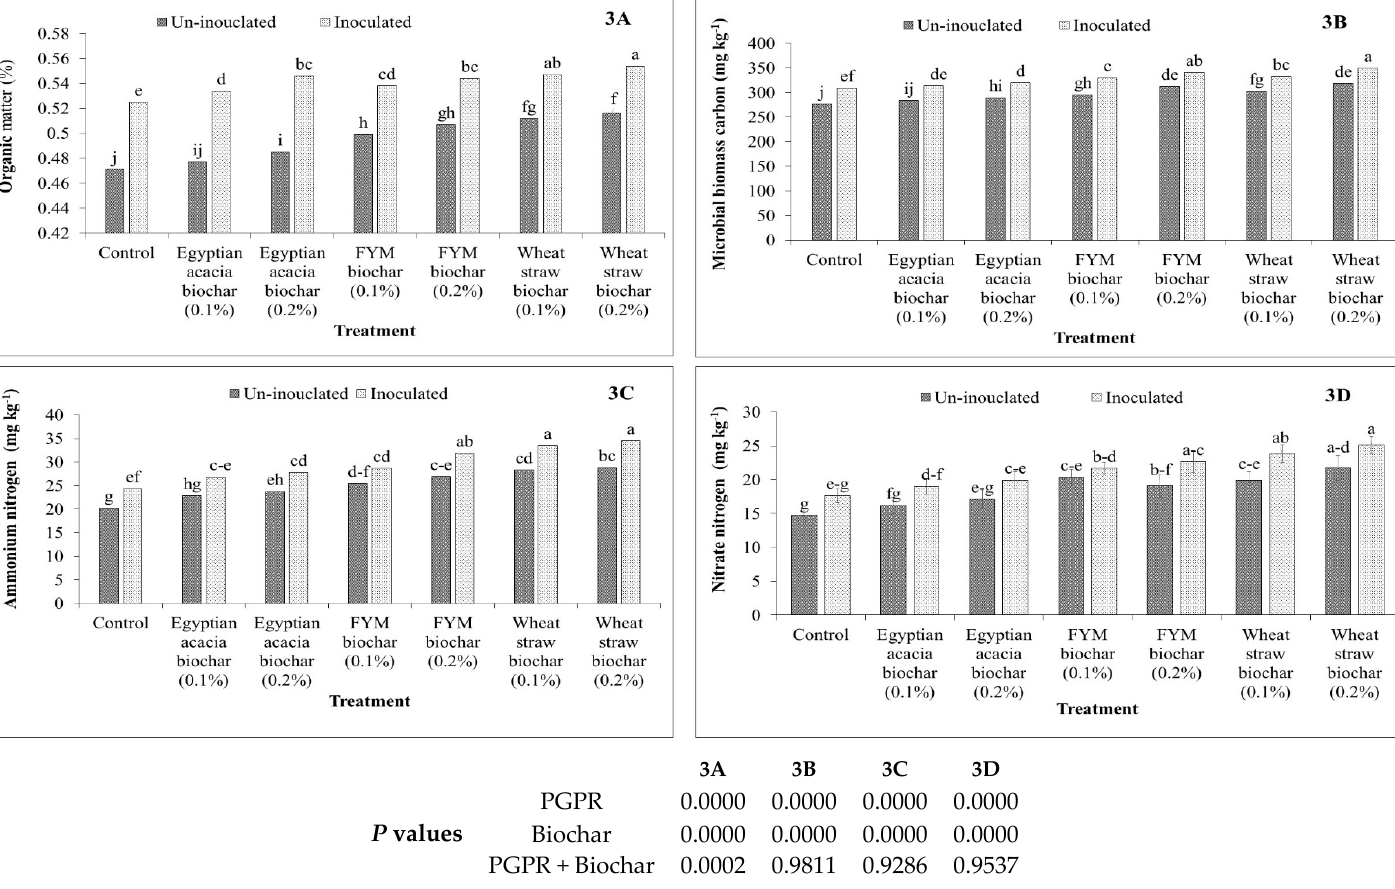
Figure 3. Effects of biochar with and without Bacillus sp. ZM20 on organic matter ( A ), microbial biomass carbon ( B ), ammonium nitrogen ( C ), and nitrate nitrogen ( D ) under field trial; ( n = 3); bars sharing same letters are statistically not different from each other at p ≤ 0.05.